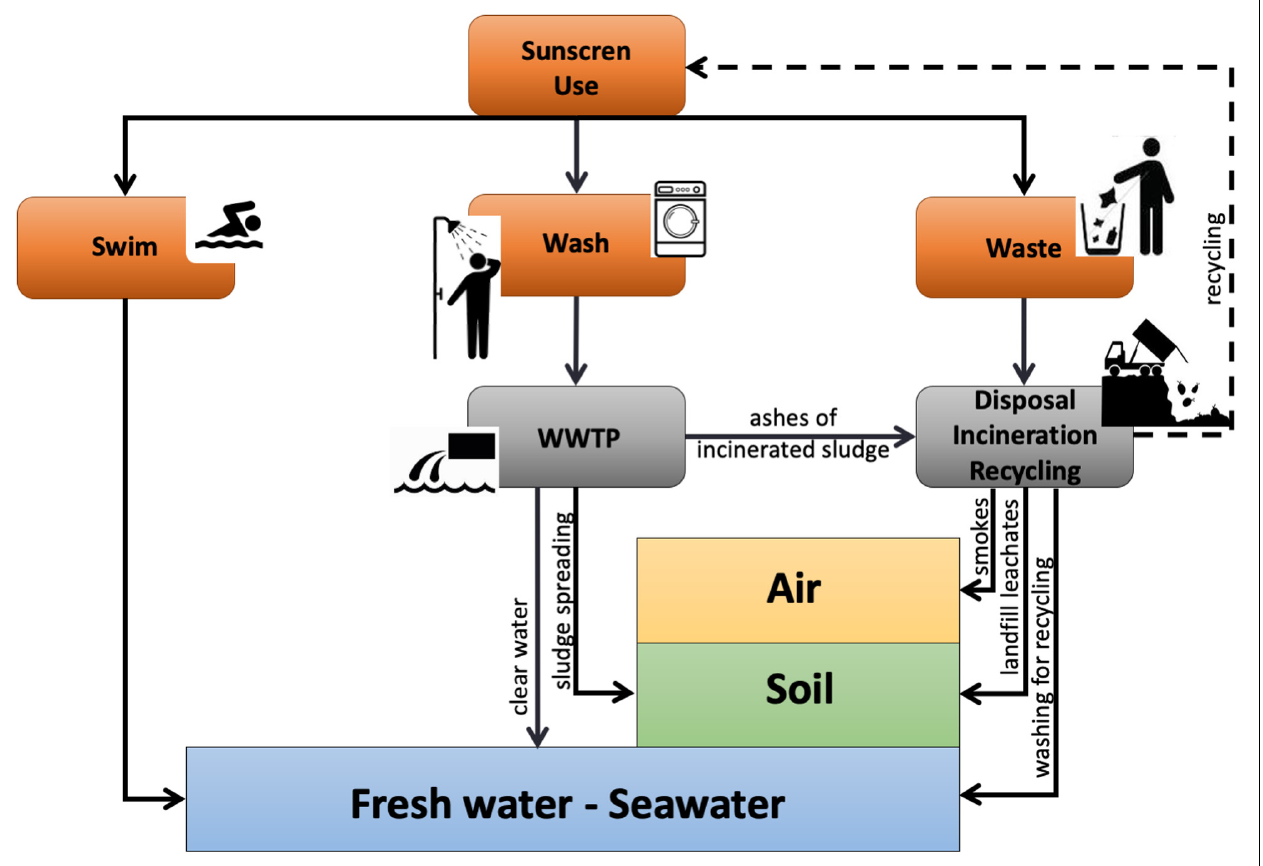
FIGURE 1 | Possible transport pathways from sunscreen use to air, water or soil, through bathing water, domestic wastewater, and solid waste disposal.